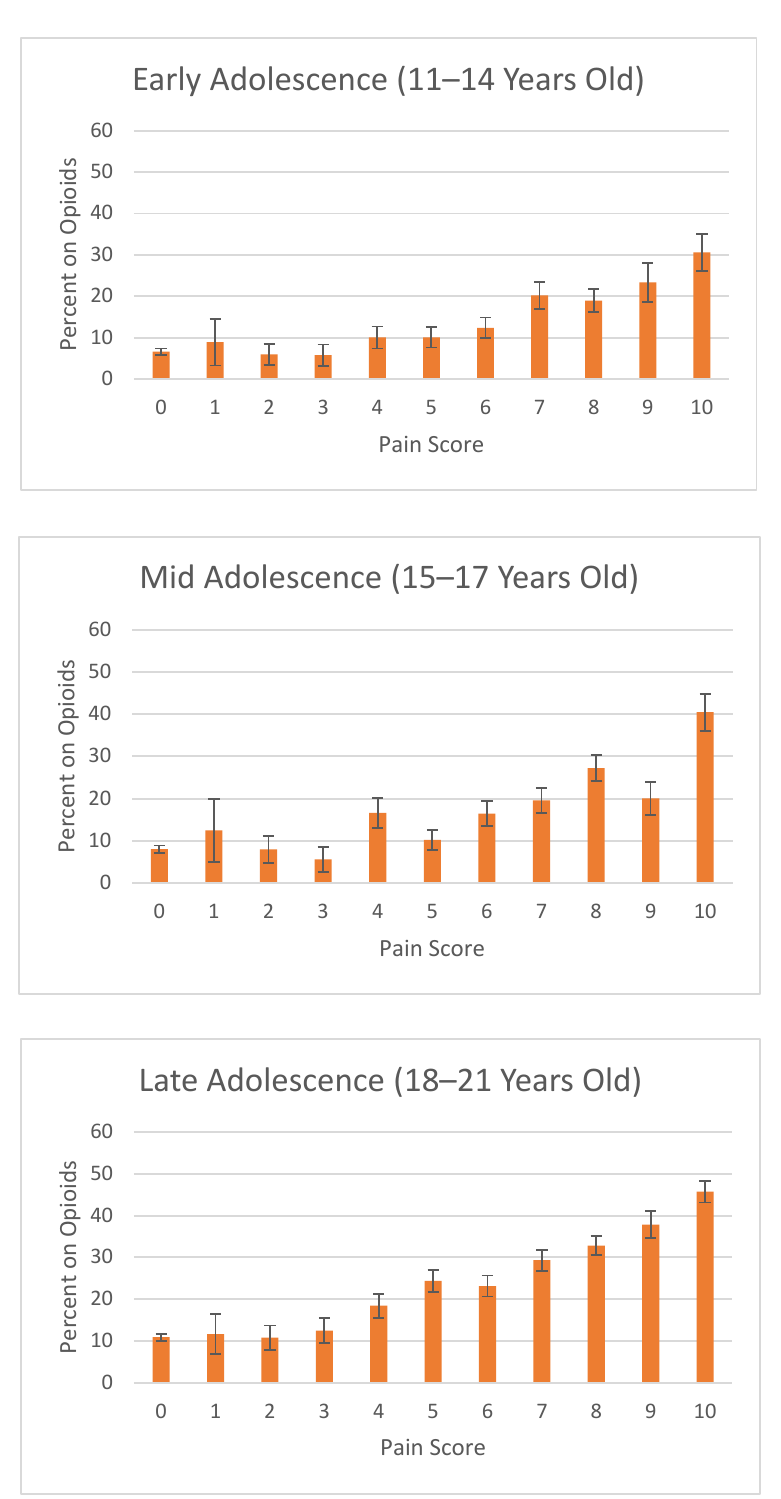
Figure 3. Proportion of Adolescent Opioid Use in the ED by Pain Score by Age Groups. Calculated using a 95% confidence interval. Age groups separated by early (11–14 years old), mid (15–17 years old), and late (18–21 years old) adolescents.